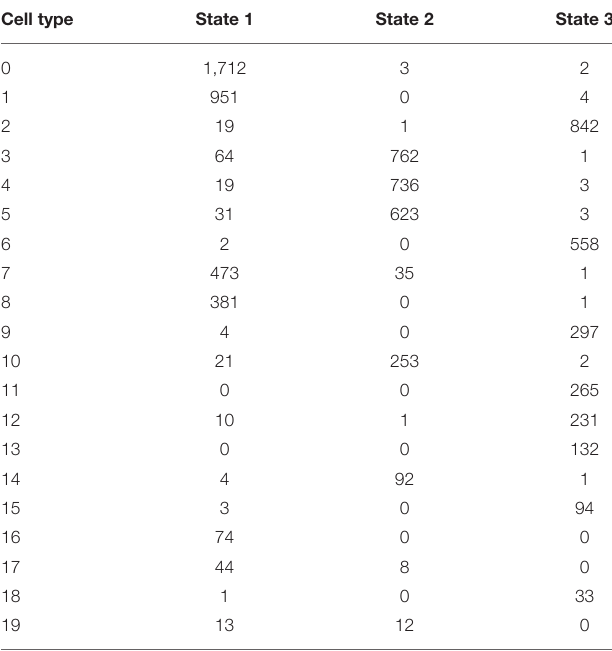
TABLE 3 | The cell counts of 20 subgroups in three types of